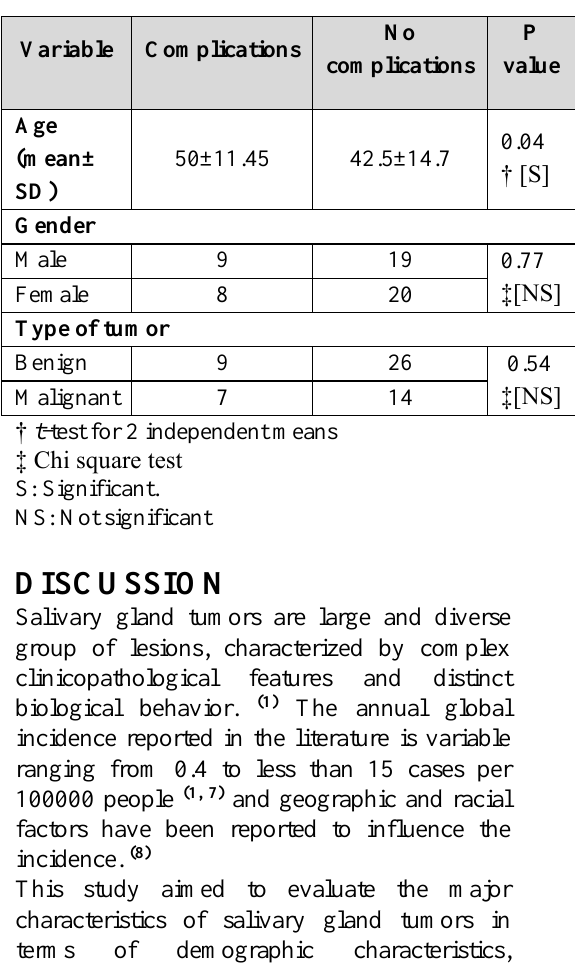
Table 3: Factors affecting complication